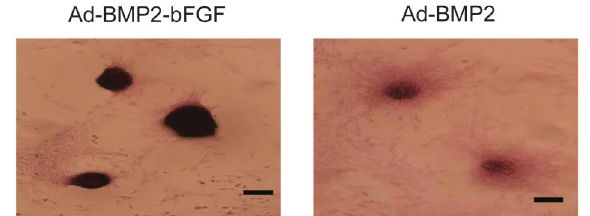
Figure 7. Kossa staining of bone marrow progenitor cells 21 days after infection with Ad-BMP2-bFGF or Ad-BMP2. Mineralized calcium deposits were stained as dark nodules. Bar = 400 m m.